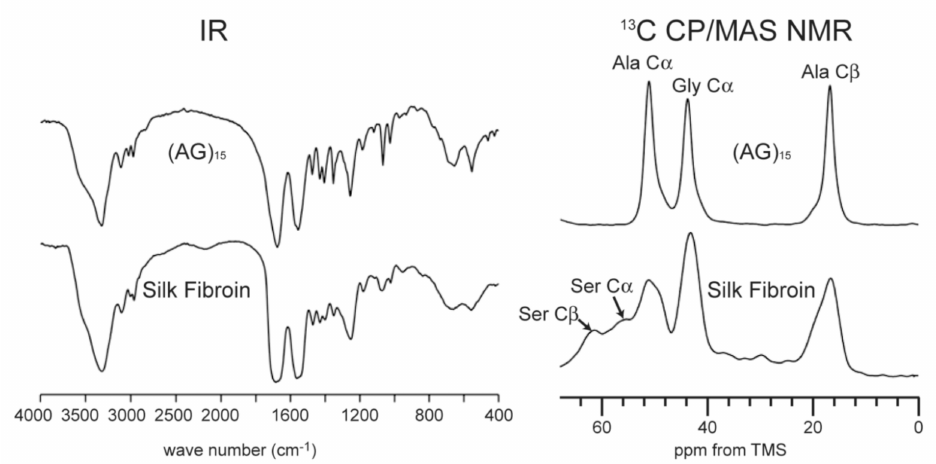
Figure 3. IR and 13 C CP/MAS NMR (0–70 ppm) spectra of (AG) 15 and B. mori silk fibroin with silk I structures [22]. Reprinted with permission from ref.